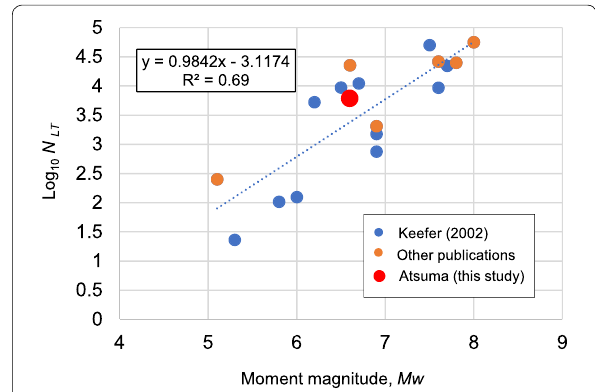
Fig. 17 Relationship between moment magnitude ( M w ) and total number of landslides ( N LT ) for 11 cases from Keefer (2002), six